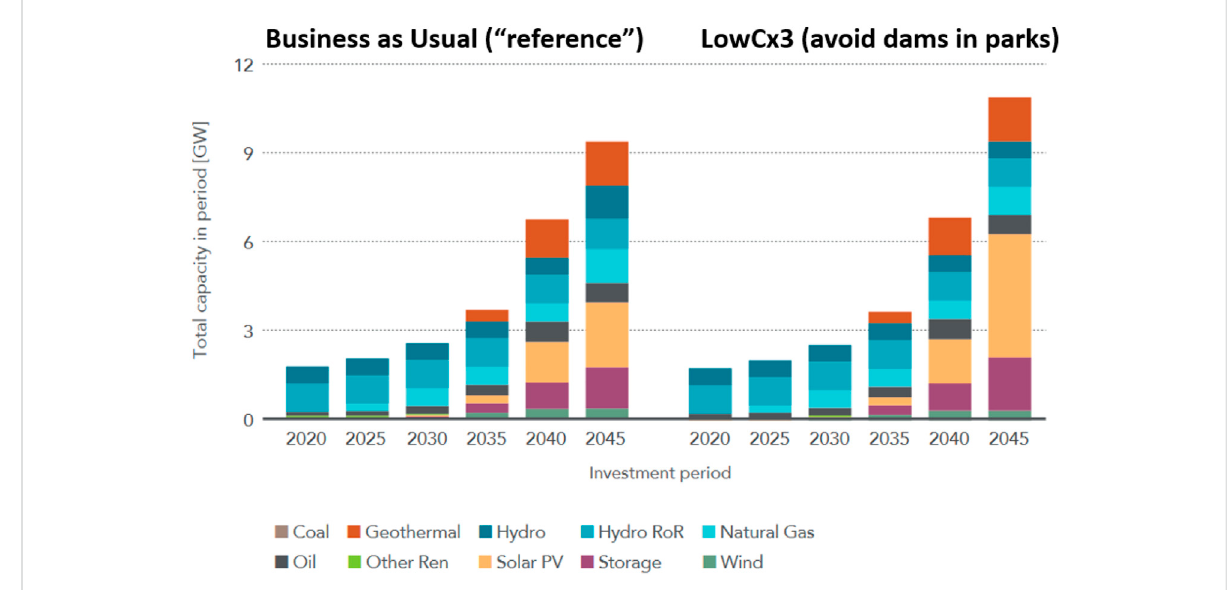
FIGURE 11 Installedcapacity,bytechnologyandtimeperiod,fortheBAUscenario( “ reference ” )anda “ LowCx3 ” scenariothatavoidedhydropowerdamsin national